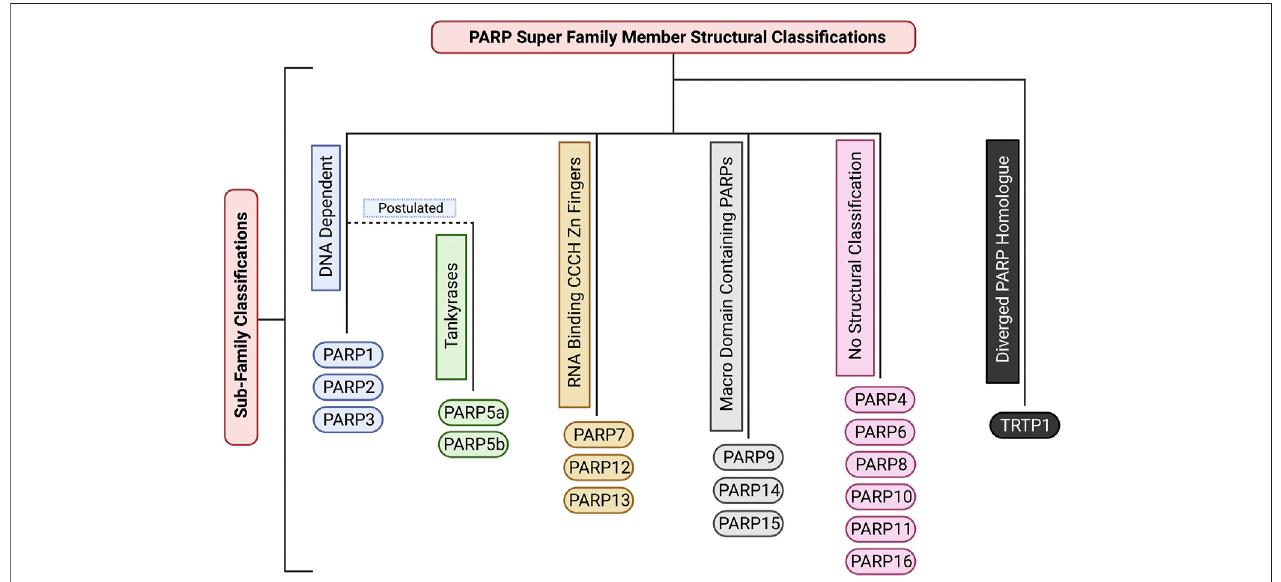
FIGURE 3 | The structural sub-classi fi cations of the PARP family. These classi fi cations include: DNA Dependent PARPs (PARP1/2/3), Tankyrases (PARP5a/5b), RNABindingCCCHZnFingerPARPs(PARP7/12/13),MacroDomainContainingPARPs(PARP9/14/15),PARPswithnosub-classi fi cation(PARP4/6/8/10/11/16),and Diverged PARP Homologues (TRTP1). Created with